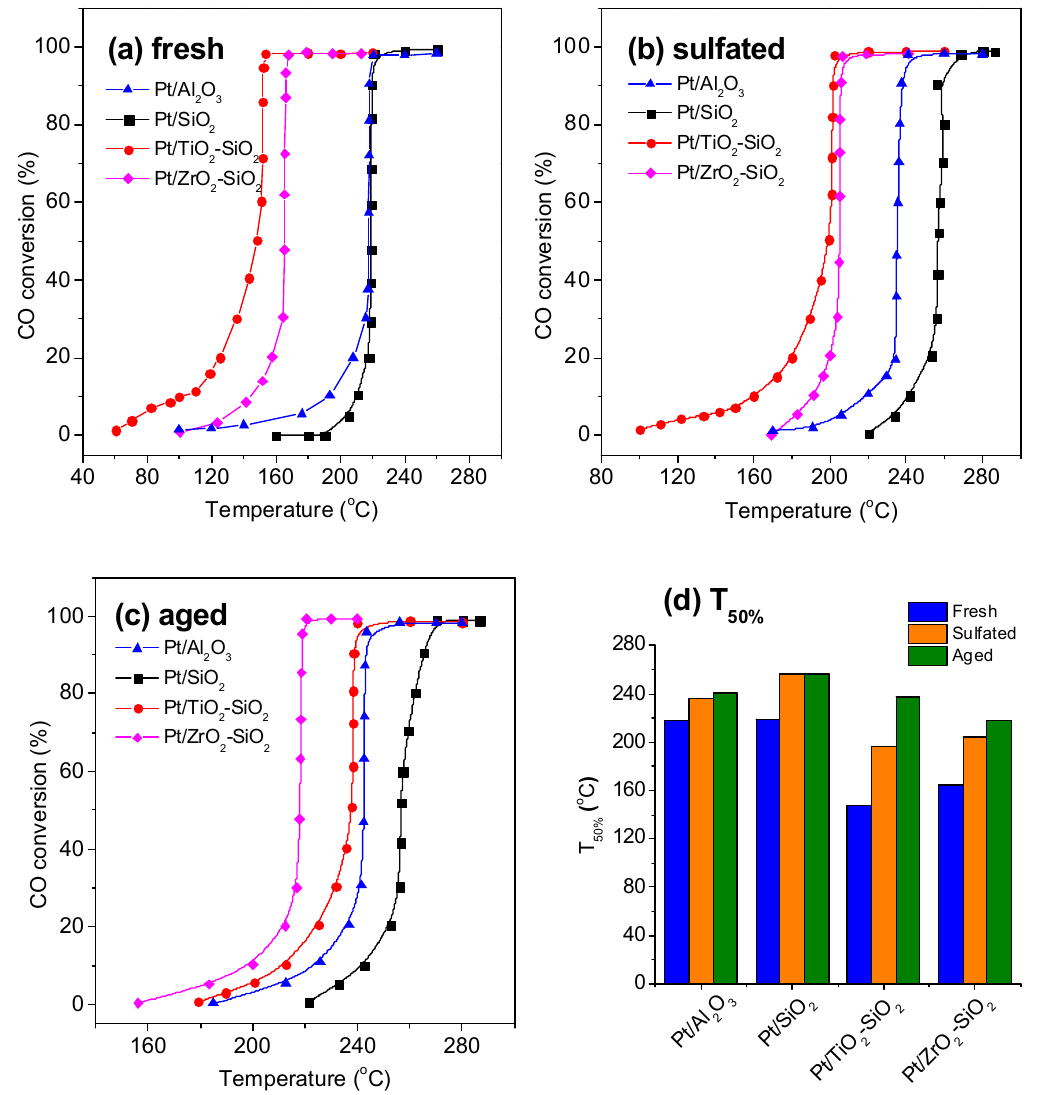
Figure 6. Catalytic performance of Pt/Al the oxidation of carbon monoxide with a total flow rate of 200 ml/min (1% CO, 4% O H O, Ar balance); ( a ) fresh catalysts; ( b ) sulfated catalysts; ( c ) hydrothermal aged catalysts 2 and ( d ) light-off temperatures ( T